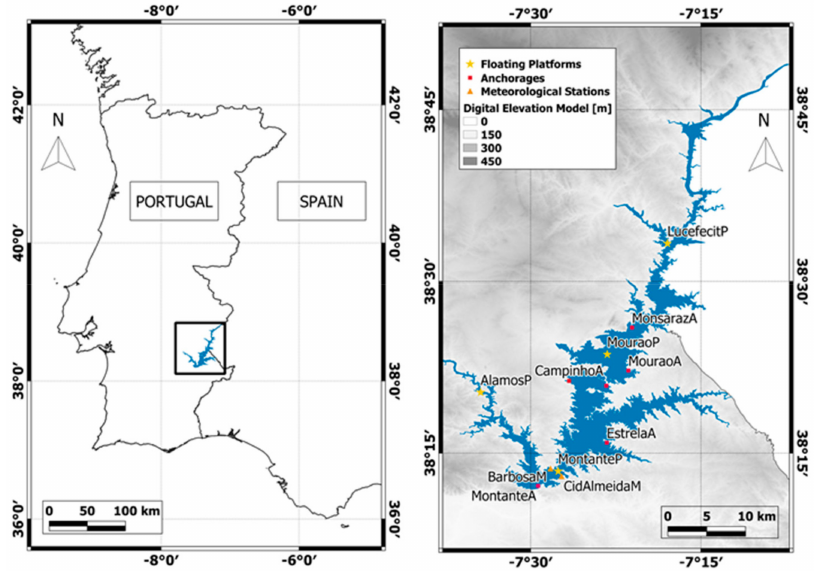
Figure 1. Alqueva reservoir and position of the sites used in this study.